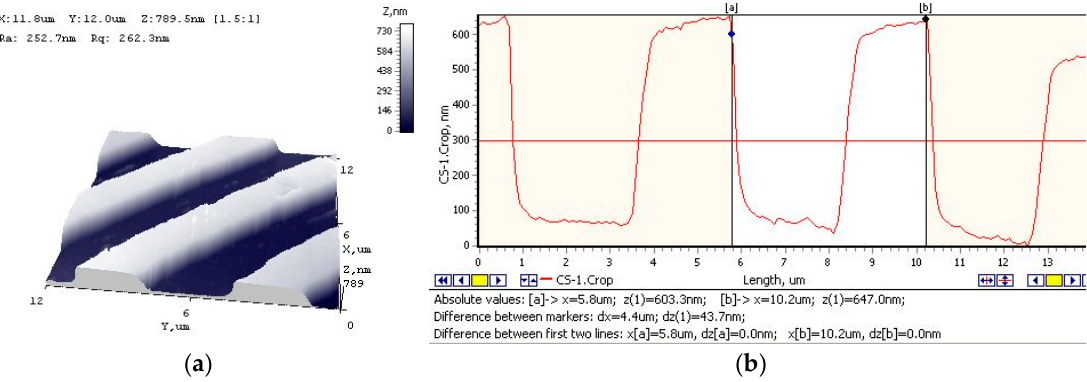
Figure 14. Replica of the microstructure: Atomic force microscope image ( a ) and cross section ( b ) of the replica: profile, lamellar; period, 4 µm; land, 2 µm; ridge, 2 µm; depth, 560 µm.